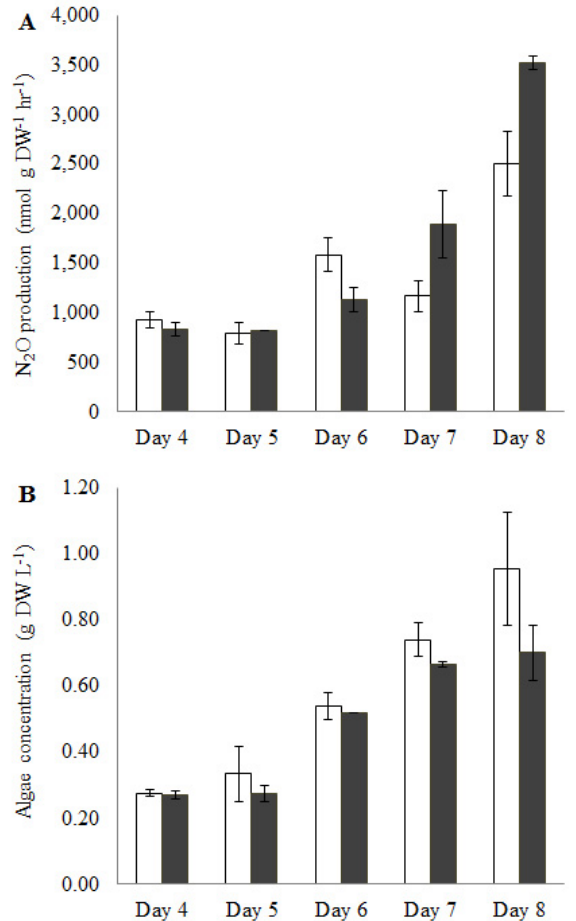
Fig. 2. Evolution of specific N 2 O production (A) and biomass con- centration (B) in antibiotic-laden (grey bars) and antibiotic-free (white bars) C. vulgaris cultures. The rates shown represent aver- ages from duplicates and were determined between 4 and 24h after nitrite addition (12mM).